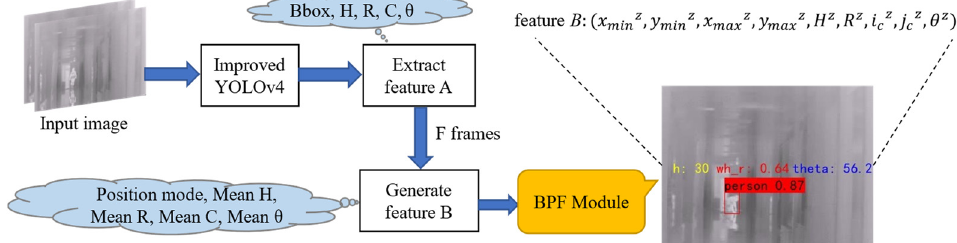
Figure 7. Flow chart for establishment behavior parameter field.